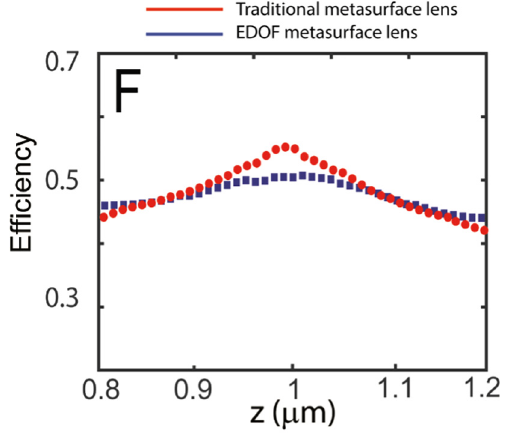
Figure 6: Experimentally measured focusing efficiency of 1 mm EDOF and traditional metalenses as a function of distance along the optical axis.